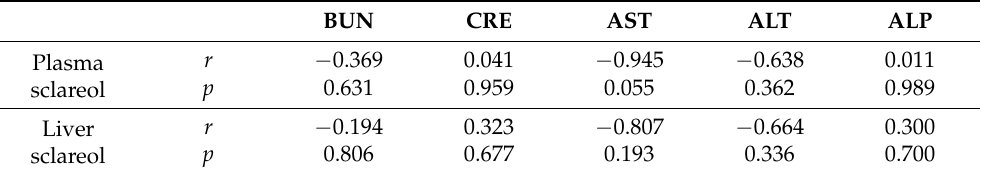
Table 2. Correlations among the plasma/liver sclareol concentrations and plasma biochemical parameters based on correlation coefficients in the sclareol-administered